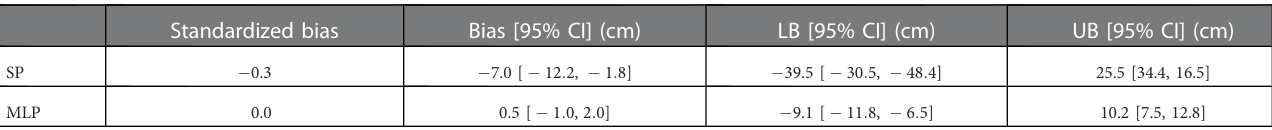
TABLE 7 Bland-Altman analysis results for the two compared